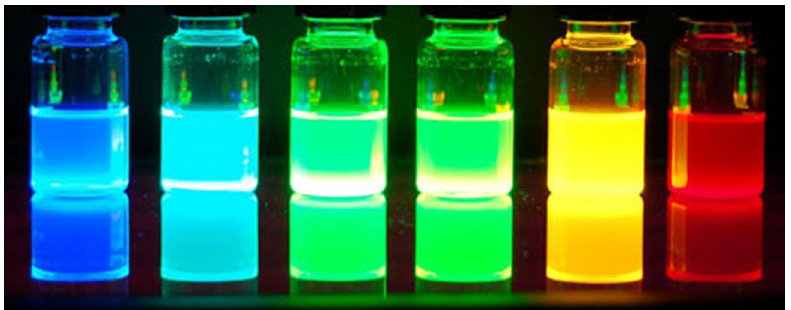
Figure 7: Photoluminescence of alloyed CdS x Se 1 − x /ZnS QDs [ 24 ]